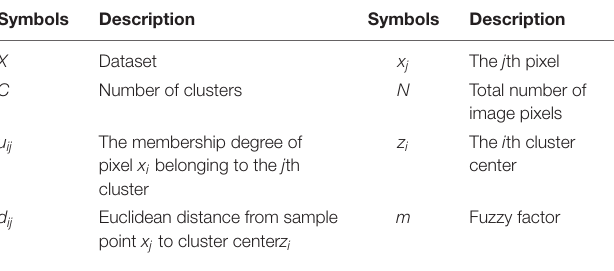
TABLE 3 | Description of related symbols in